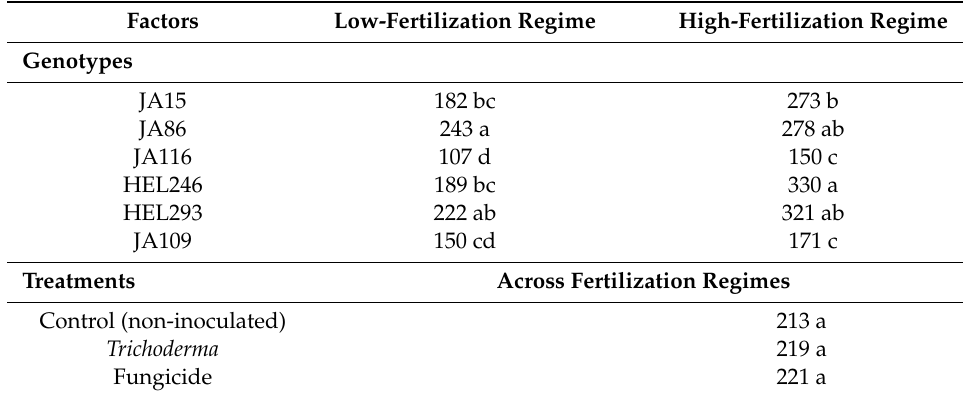
Table 3. Means of tuber yield (g / plant) under two fertilization regimes of six Jerusalem artichoke genotypes and three control methods.